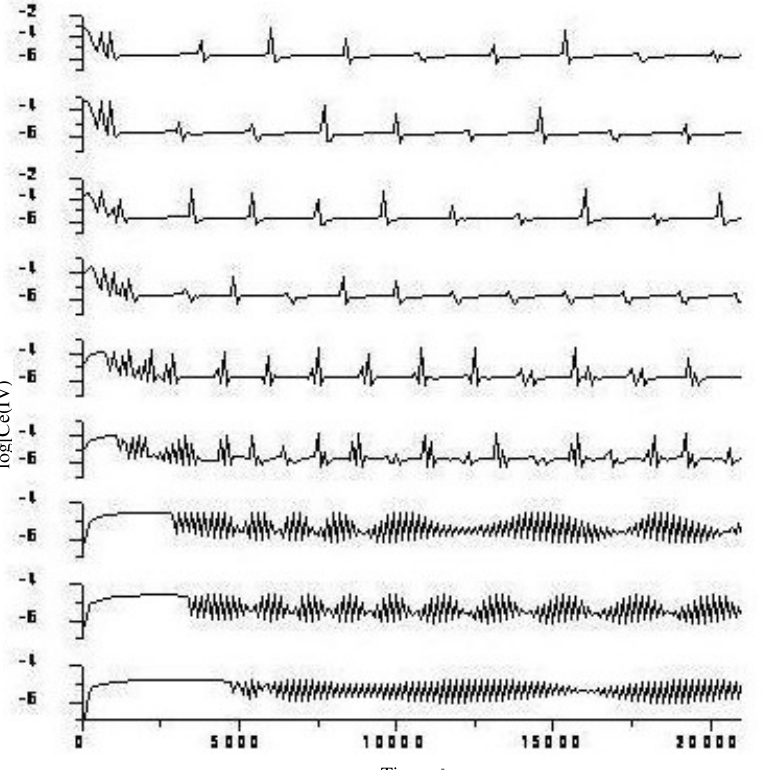
Figure 3 . Simulated plots of oscillations in [Ce(IV)] at different inflow concentrations of Ce(III) with initial concentrations of various species at 1 x 10 -10 M; Inflow concentrations of Ce(III) are (I) = 0.0005 M, (II) = 0.0008M, (III) = 0.001 M, (IV) = 0.005 M, (V) = 0.01 M (VI) = 0.05 M, (VII) = 0.1 M, (VIII) = 0.2 M, (IX) =